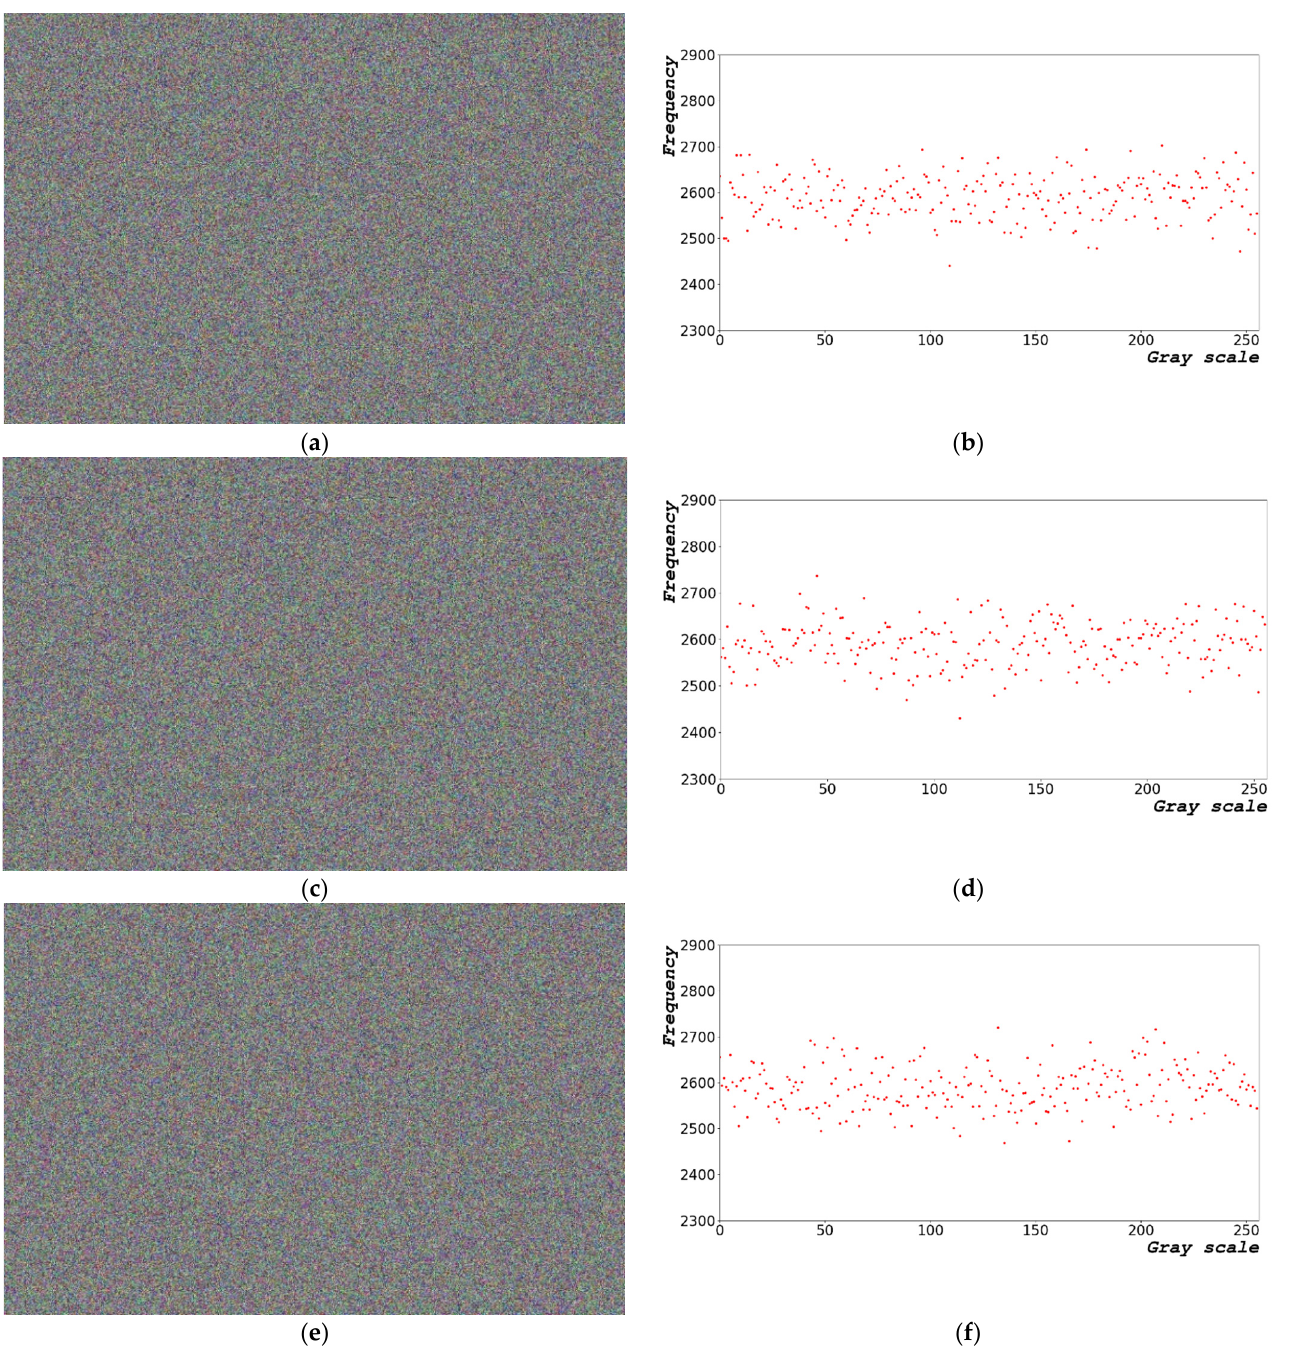
Figure 9. Random-bit generation result based on time: ( a ) image of random-bit generation measur- ing 1000 × 663; ( b ) distribution diagram chart of entropy generation with size ranging from of 0 to 255 and 8 bits at dx = 0.1156 rad; ( c ) image of random-bit generation measuring 1000 × 663; ( d ) dis- tribution diagram chart of entropy generation with size ranging from 0 to 255 and 8 bits at dx = 0.2312 rad; ( e ) image of random-bit generation measuring 1000 × 663; and ( f ) distribution diagram chart of entropy generation with size ranging from 0 to 255 and 8 bits at dx = 1.1560 rad. Figure 10a,d,g show the same ultrasound abdomen phantom images. Figure 10b,e,h show the 1000 × 663 random-bit generation visualization image at dx = 0.1156, 0.2312, and 1.1560 rad, respectively. Figure 10c,f,i show the randomized ultrasound images obtained by combining the ultrasound and random-bit generation visualization images at dx = 0.1156, 0.2312, and 1.1560 rad, respectively.